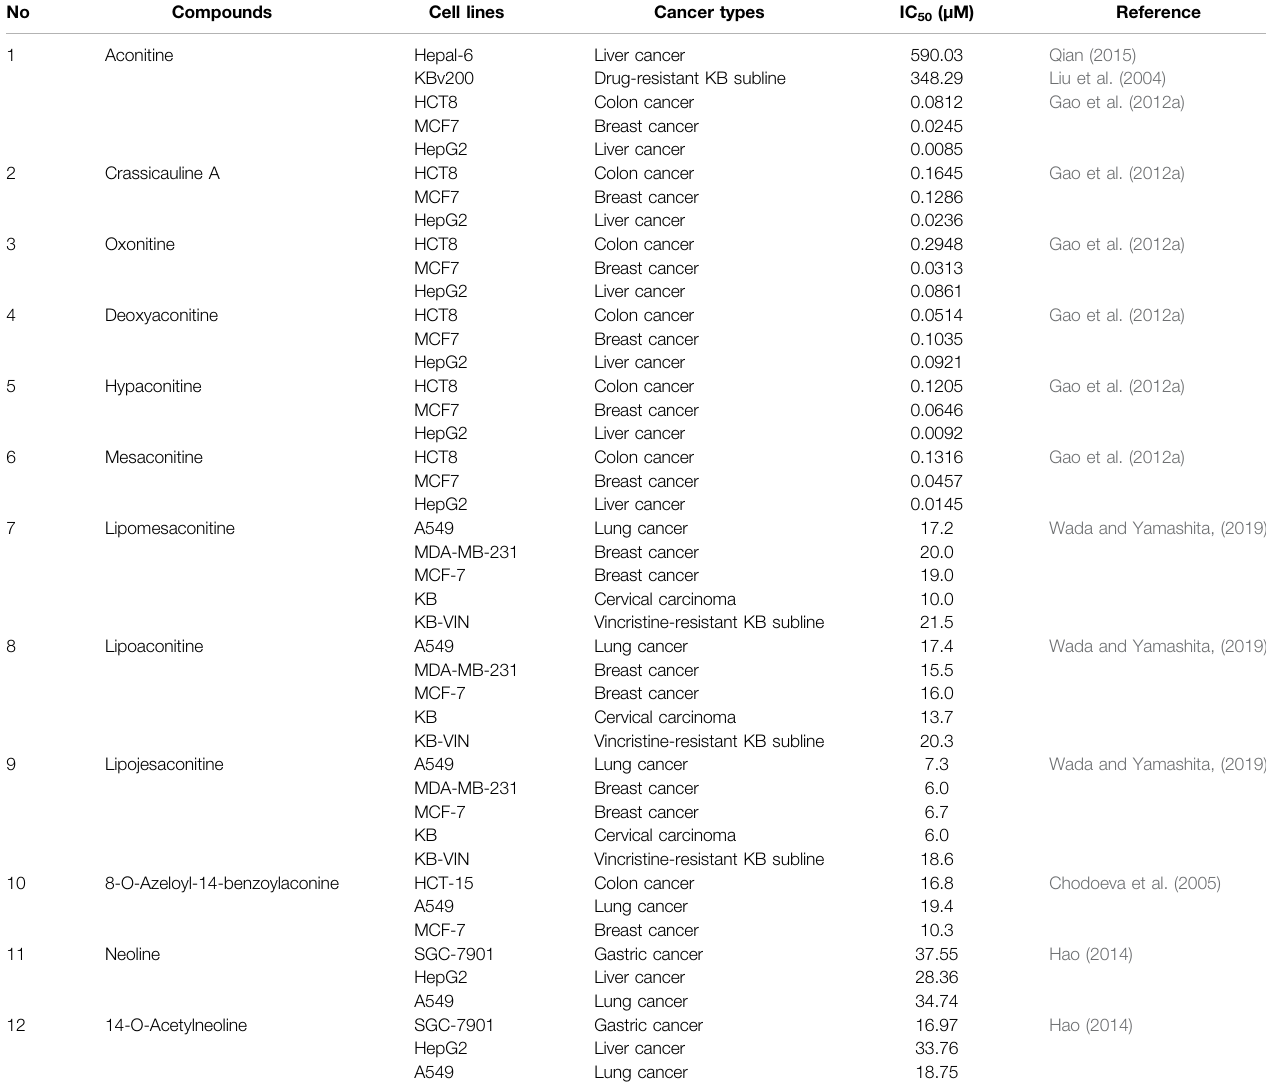
TABLE 2 | Cytotoxicity of C 19 diterpenoid alkaloids and their derivatives in different cancer cell lines.